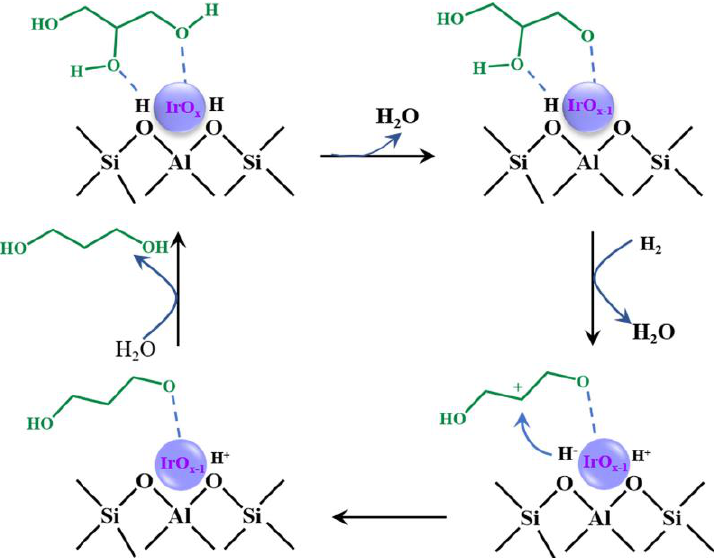
Figure 11. The mechanism for the formation of 1,3-PG in the presence of IrO x /H-ZSM-5. Reproduced from [82] with permission from Elsevier.